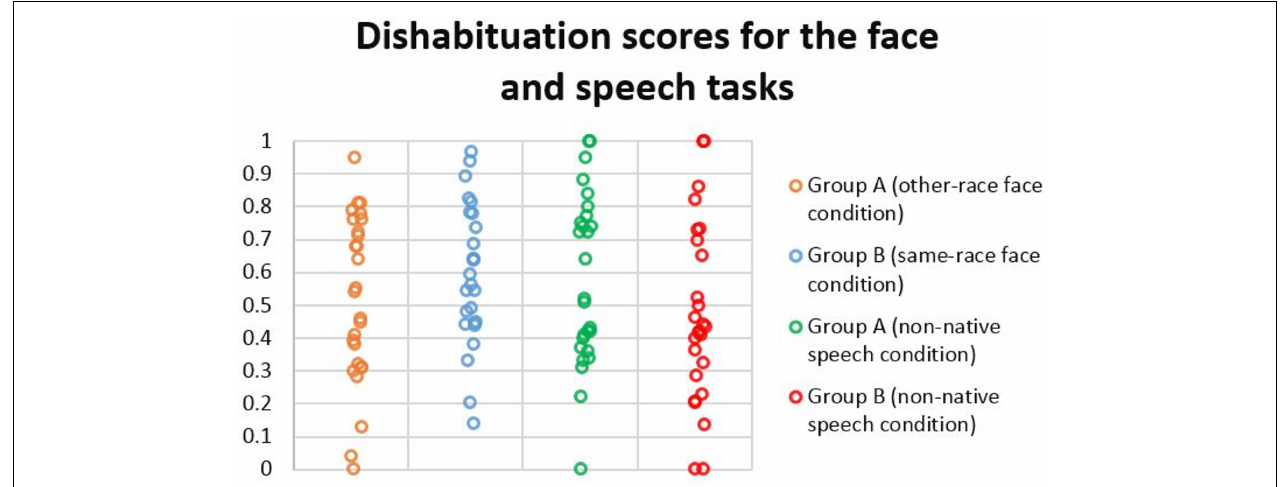
FIGURE 1 | Dishabituation scores for the face and speech tasks.